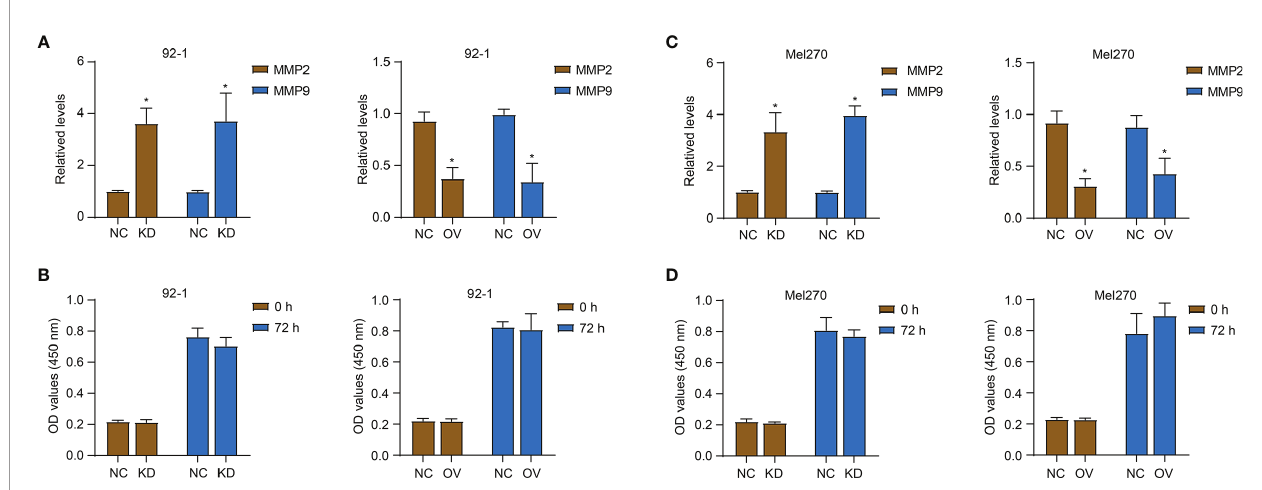
FIGURE 4 | PALMD on MMP expression and proliferation of UM cells. After transfection of siRNA speci fi cally targeting PALMD (KD) or pcDNA3.1 overexpression plasmid (OV), the MMP2 and MMP9 expression of 92-1 (A) and Mel270 (B) cells was measured with ELISA, the proliferation of 92-1 (C) and Mel270 (D) cells was detected with CCK-8 assay. *P <